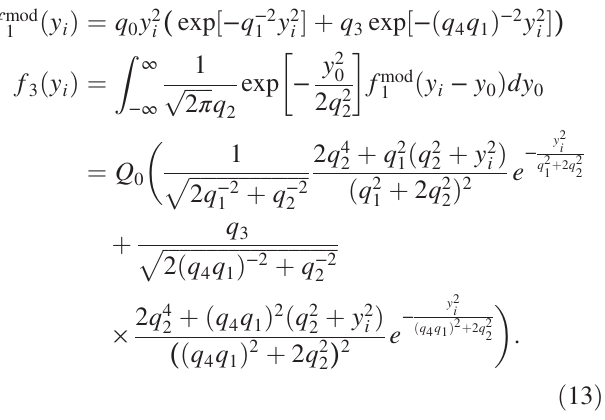
FIG. 9. SPF distribution of Fig. 7 plotted on a logarithmic scale (red circles) together with fit based on f mod 1 ð y i Þ Eq. (13) (red line). In addition, the individual contributions from the fit of the central lobe (blue solid line) and the side lobes (blue dashed line) are